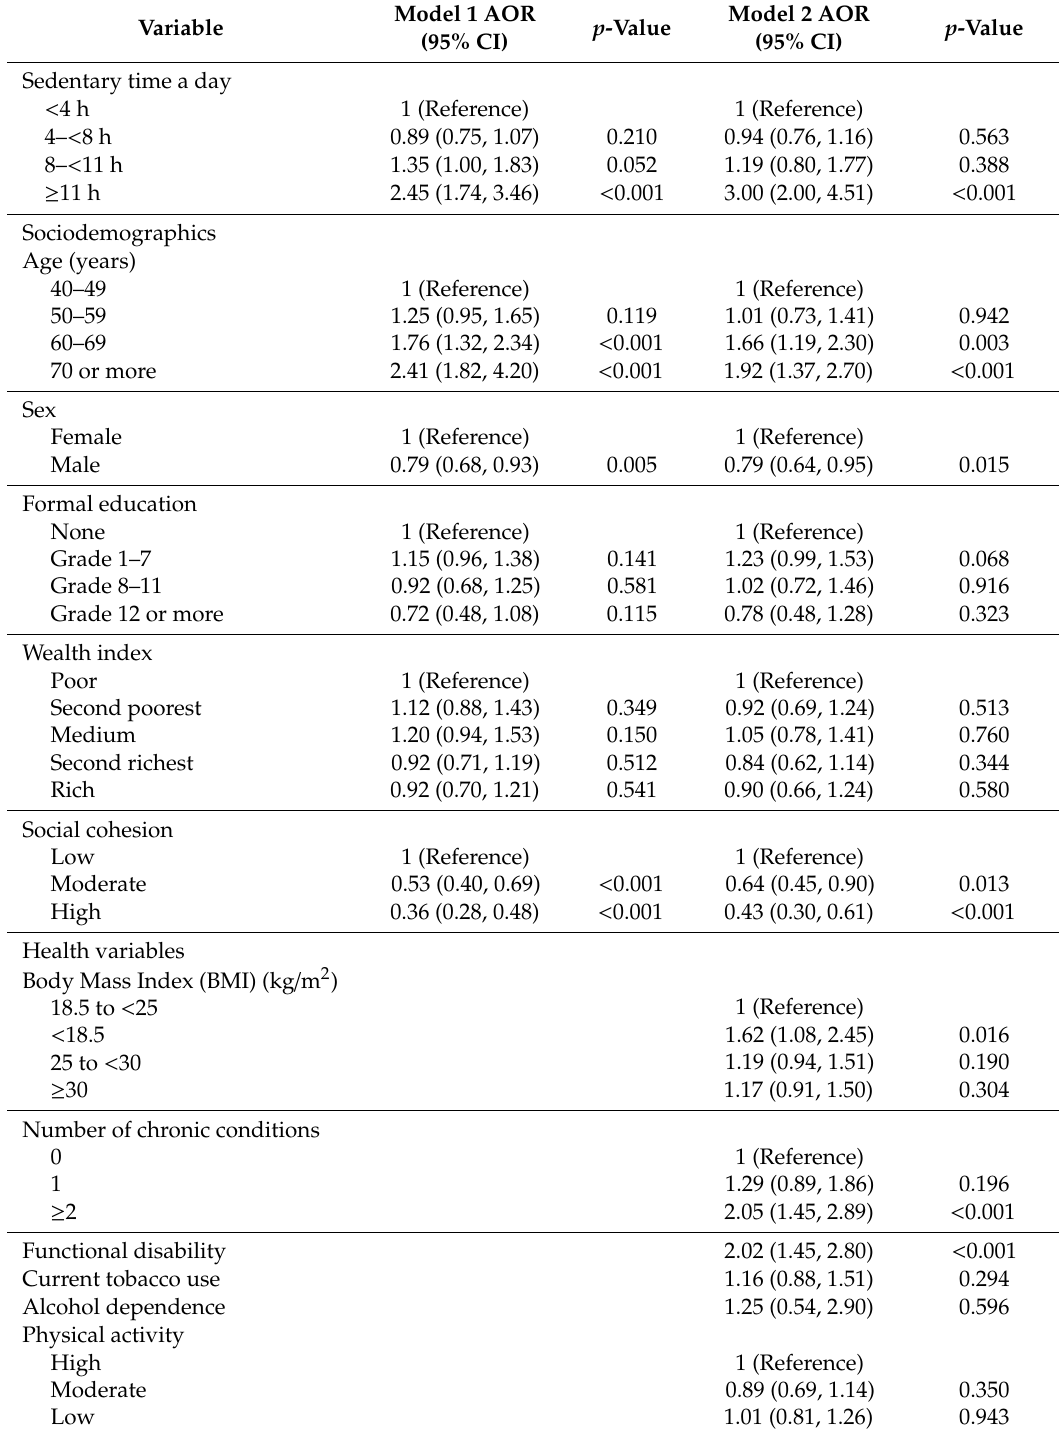
Table 2. Odds ratios for depression according to levels of sedentary